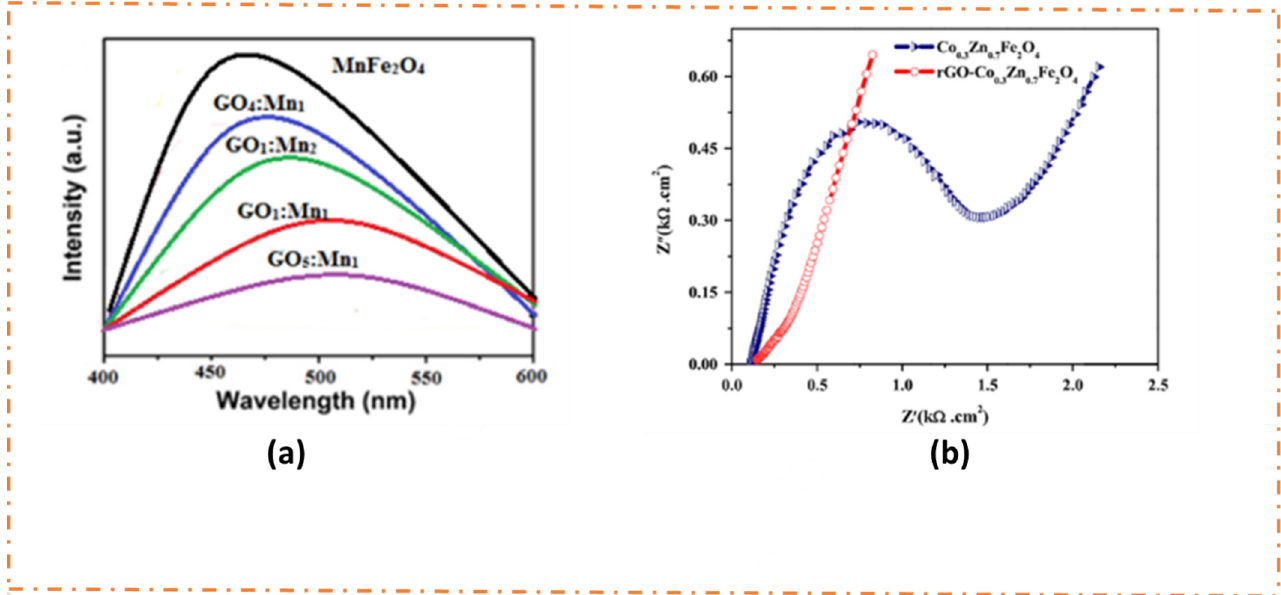
Figure 3. ( a ) PL spectra of MnFe 2 O 4 and MnFe 2 O 4 /graphene composites (GO 4 :Mn 1 , GO 2 :Mn 2